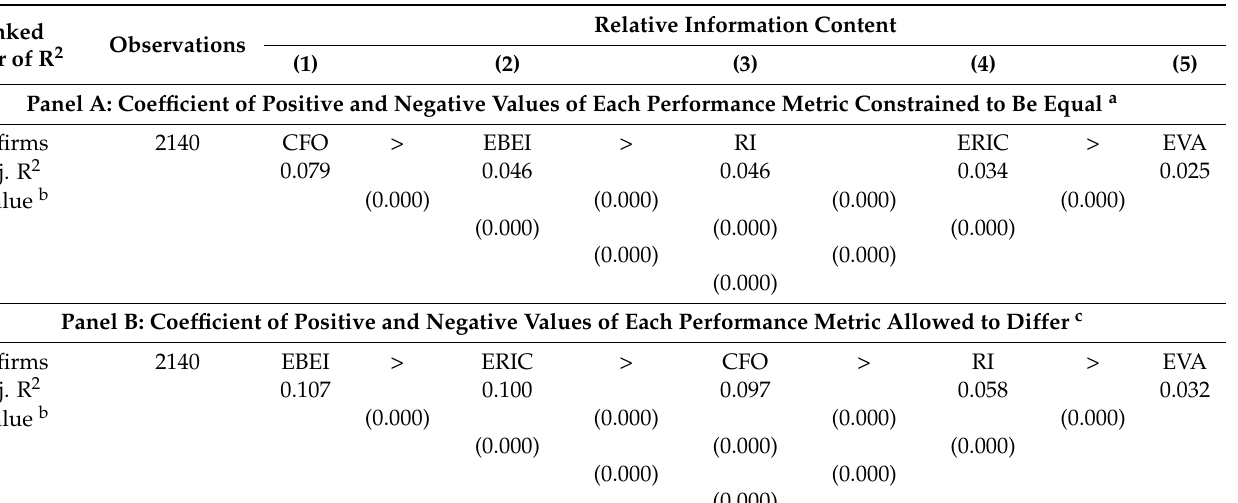
Table 2. Tests of the relative information content of CFO, EBEI, RI, EVA, and ERIC when predicting 1-year stock returns.